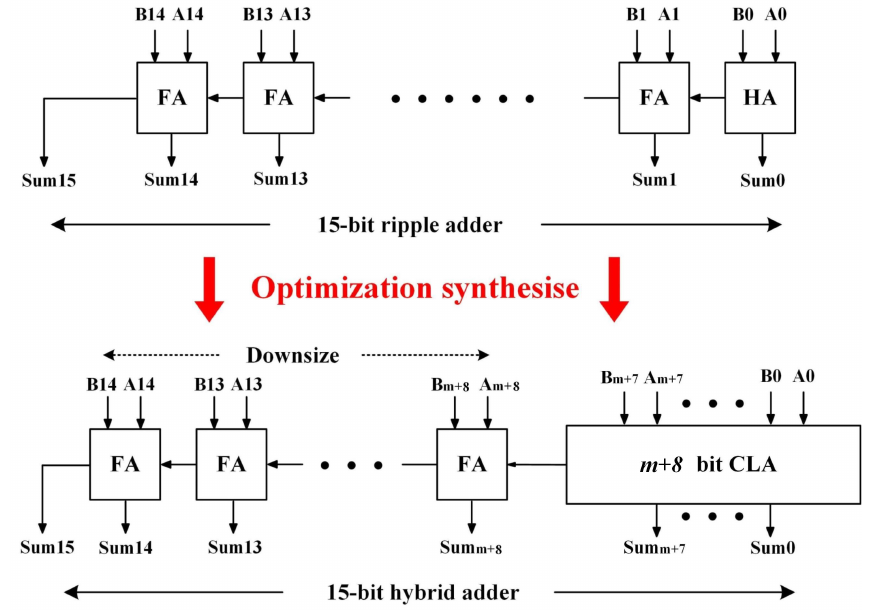
Figure 6. An example of the proposed synthesis approach.